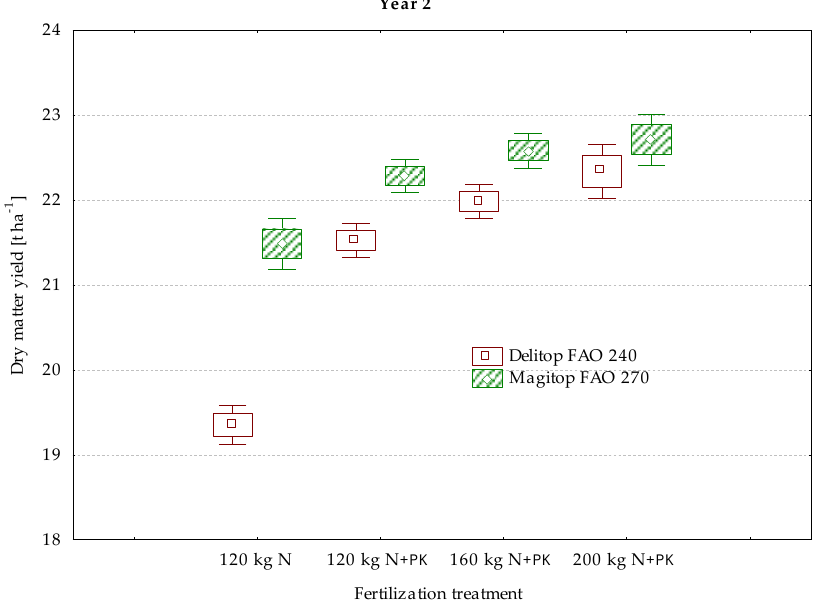
Figure 5. Boxplot of DMY of two maize varieties in the second year of the study.